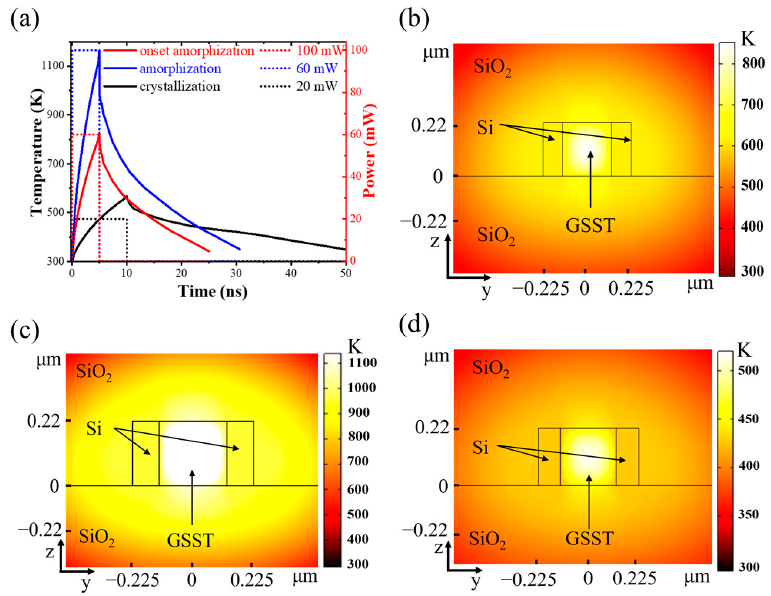
Figure 5. ( a ) Temperature response of GSST and input optical pulse; 2D cross-sectional temperature distribution at the slot for GSST ( b ) onset amorphization, ( c ) complete amorphization, and ( d ) crystallization.